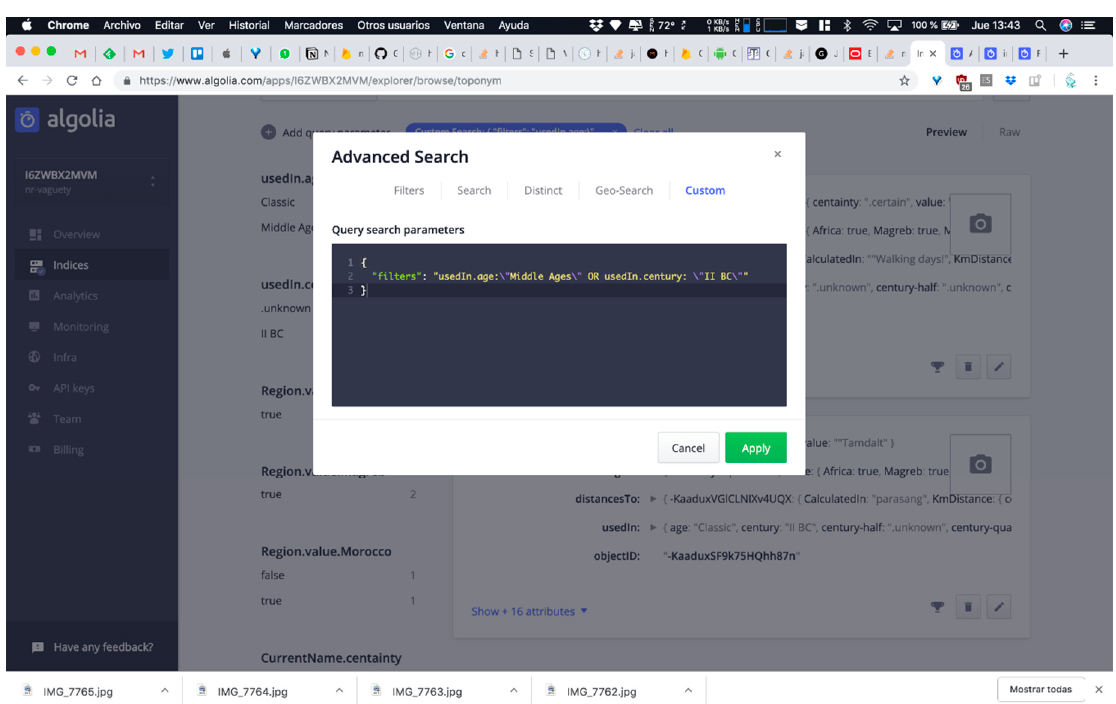
Figure 12. Query C execution through Algolia search engine. We have added a custom expression on the Algolia console with an OR expression for executing it.